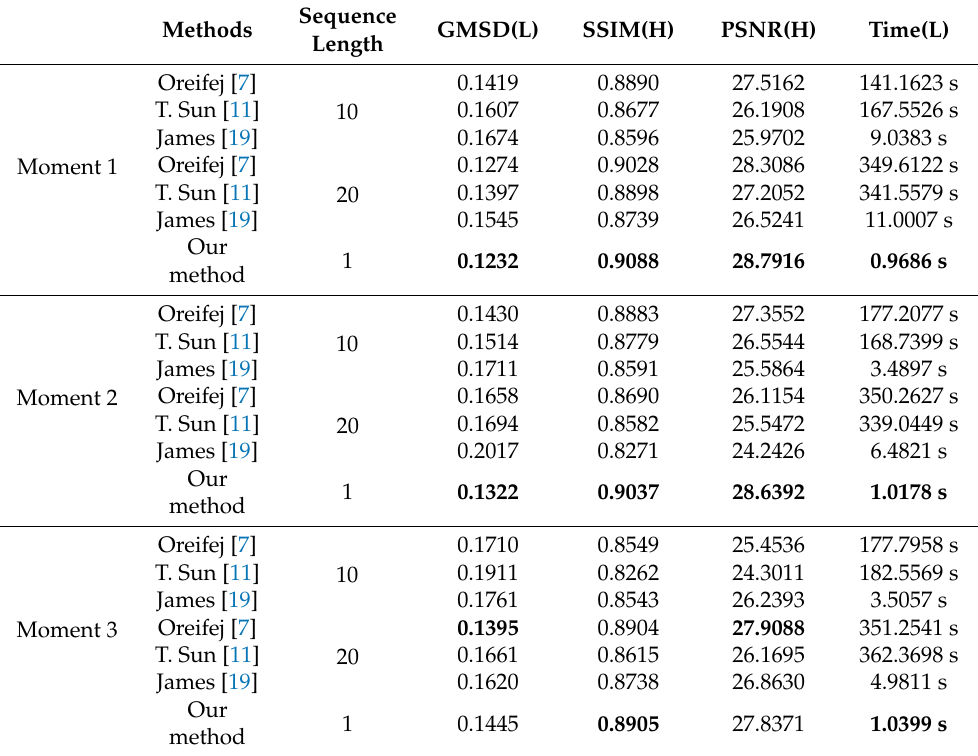
Table 2. Numerical comparison based on the real scene datasets [51] (bold values are the best).